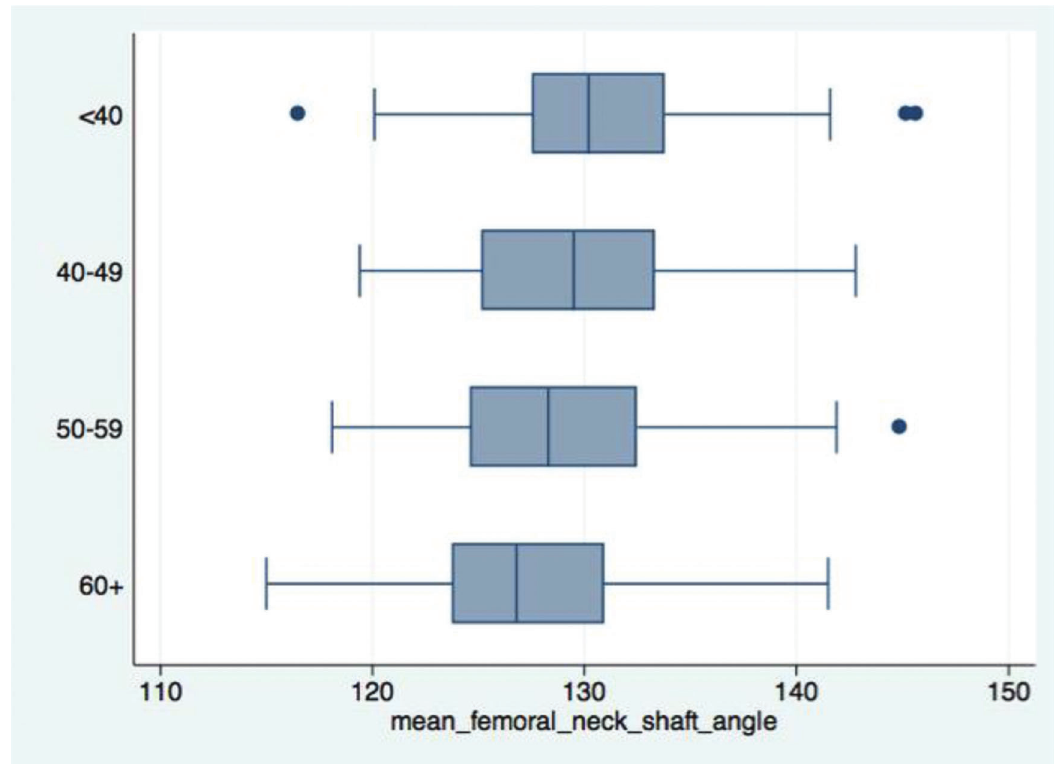
Figure 6 - Box Plots: negative association between age and femoral neck–shaft